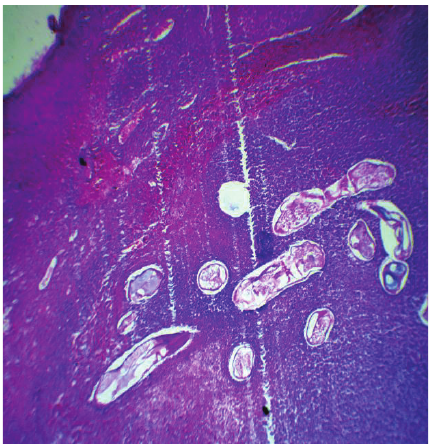
Figure 1: HE × 100: cuticle segments of adult worms containing microfilariae on a necrotico inflammatory and